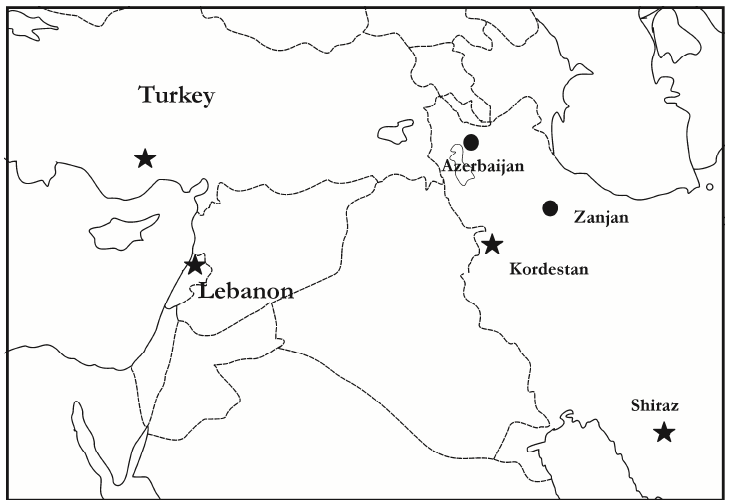
Black circles correspond to the new haplotypes for M. socialis in Iran (Zanjan and Azerbaijan). The best fitting models of sequence evolution were determined for both BI and ML methods using jModeltest 0.1.1 (Posada, 2008).The GTR model + gamma distribution (G) + proportion of invariable sites (I) (G=0.4697 and I=0.4678) based on Bayesian Information Criterion (BIC) were used to construct the BI tree. Four Monte Carlo Markov chains were run simultaneously for 2,000,000 generations. The trees were sampled every 100 th generation after removing the first 5000 trees as the burn-in stage, and branch support was assessed as Bayesian posterior probabilities (BPP). The ML tree reconstruction was performed based on the Akaike Information Criterion (AIC), with GTR+I+ G model. The branch support of the ML tree, assessed as bootstrap value (BP) with 100 replicates. We considered a BPP≥ 0.95 as ‘good’ and BPP=0.90–0.95 as ‘moderate’ supports, while BP > 90% as 'good' support, and BP = 80–90% as 'moderate' support, in line with other authors (e.g., Krystufek et al., 2009). The phylogenetic trees were rooted by three species